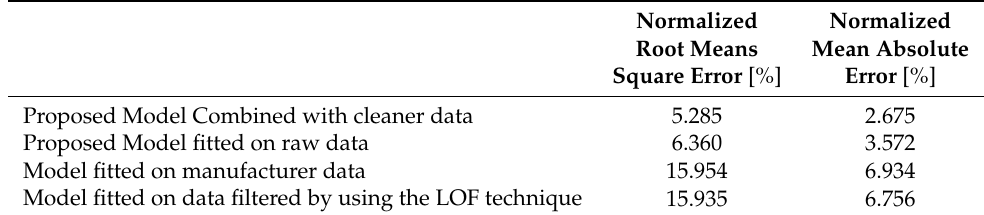
Table 3. Performance Index of Accuracy, WTG